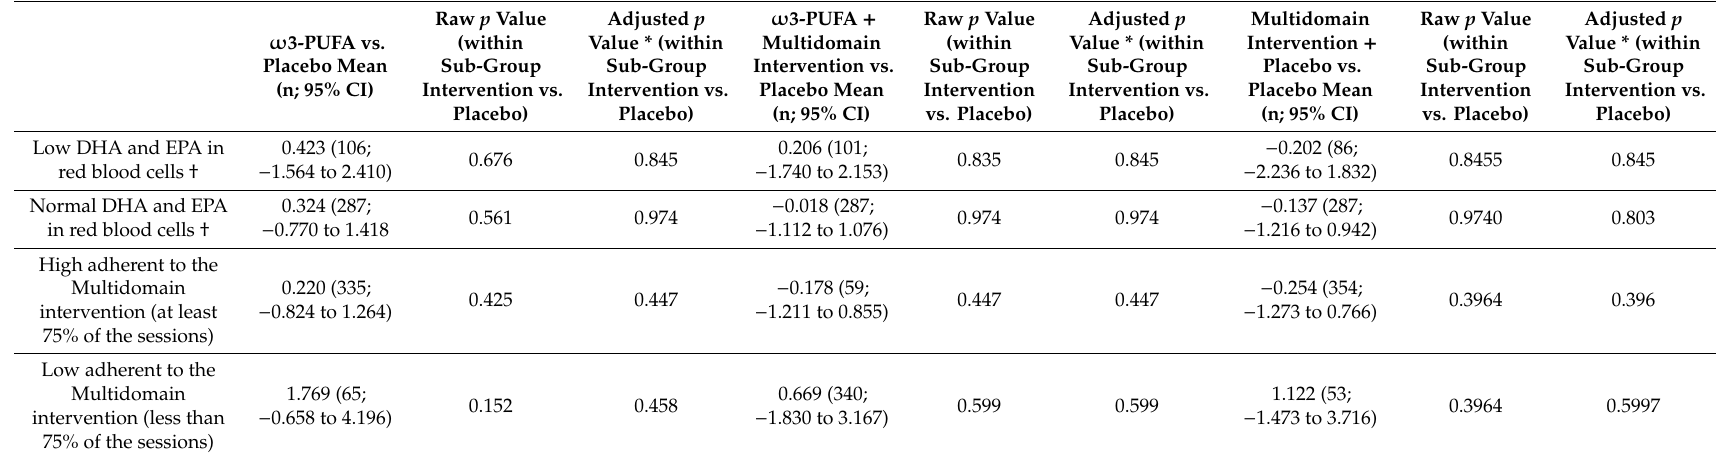
Table 6. Estimated 3-year mean di ff erence in change from baseline on handgrip strength in the three intervention groups compared with the control group (95% CI).